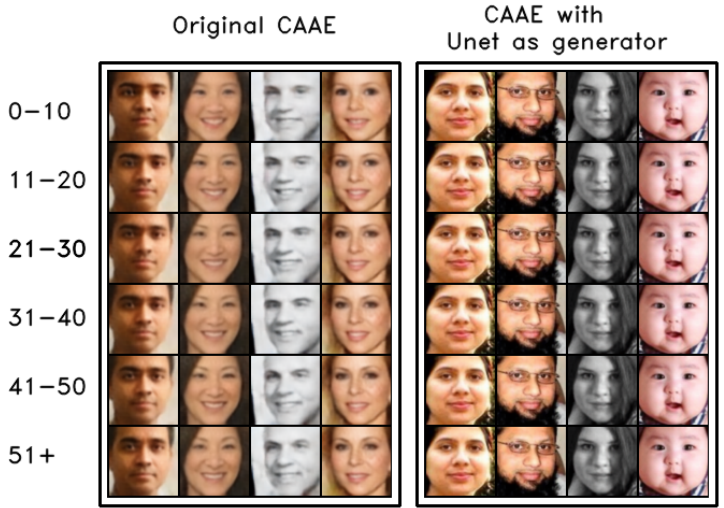
Figure 6. The results based on CAAE with and without the Unet generator. With the impact of reconstruction loss, the output images look exactly the same as the input images.